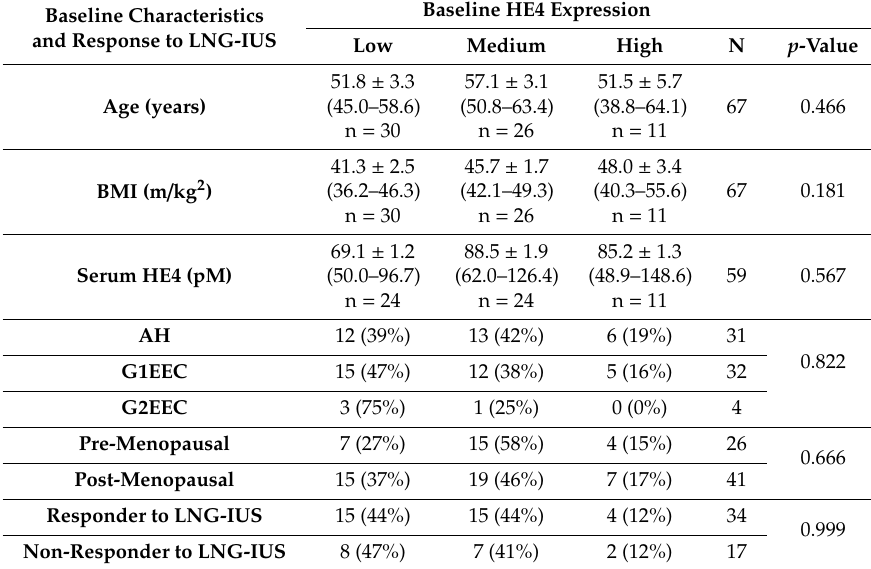
Table 4. Mean baseline age, body mass index (BMI) and serum HE4 in biopsies with low, medium and high HE4 expression, and proportion of patients with low, medium and high baseline HE4 expression according to grade, menopausal status and response to the LNG-IUS. 95% confidence interval (CI) in